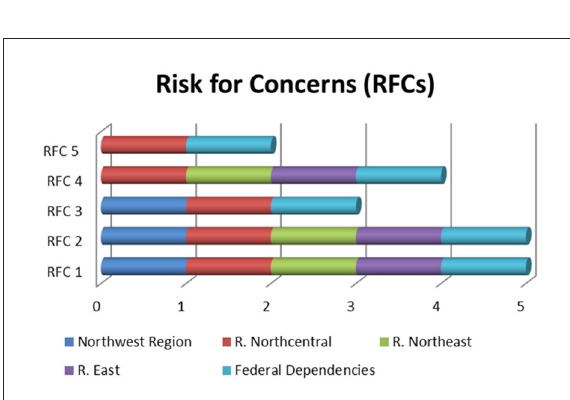
FIGURE7 Coastal risks related to climate change. Regions of Venezuela: Northwest, Northcentral, Northeast, East, and Federal Dependencies.